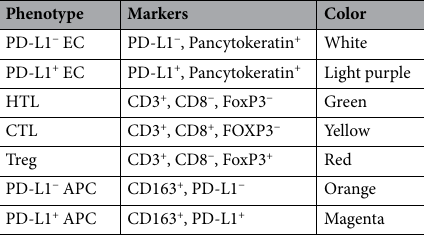
Table 1. Cellular phenotype and